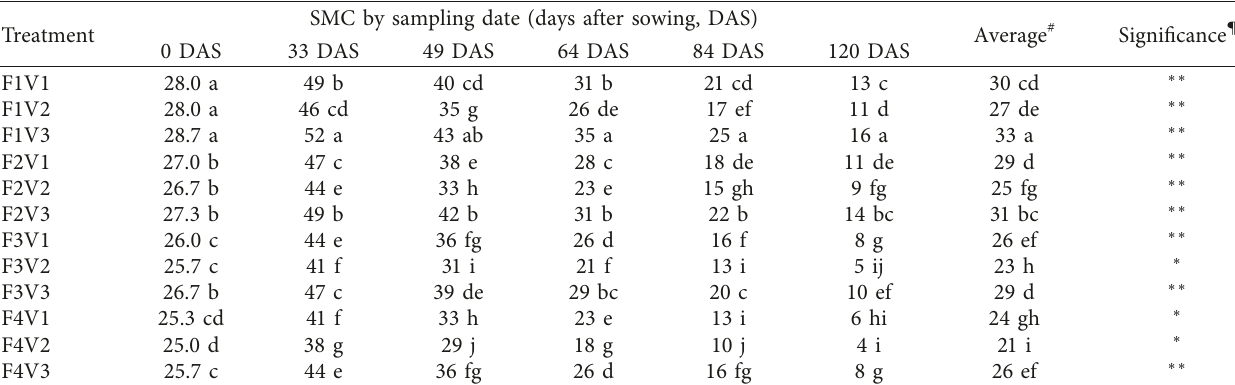
Table 5: Combined effects of N +P fertilizer rates with tef crop varieties on soil moisture content (SMC) determined at the different growth stages (sampling dates) in the 2013 cropping season in the Dura area, northern Ethiopia. SMC by sampling date (days after sowing, Treatment